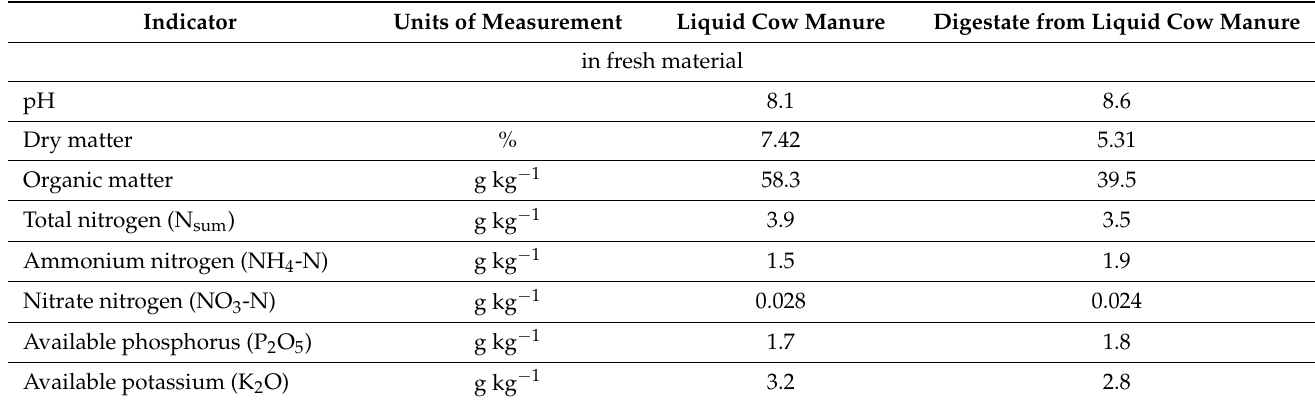
Table 1. Chemical composition of manure and digestate used in the